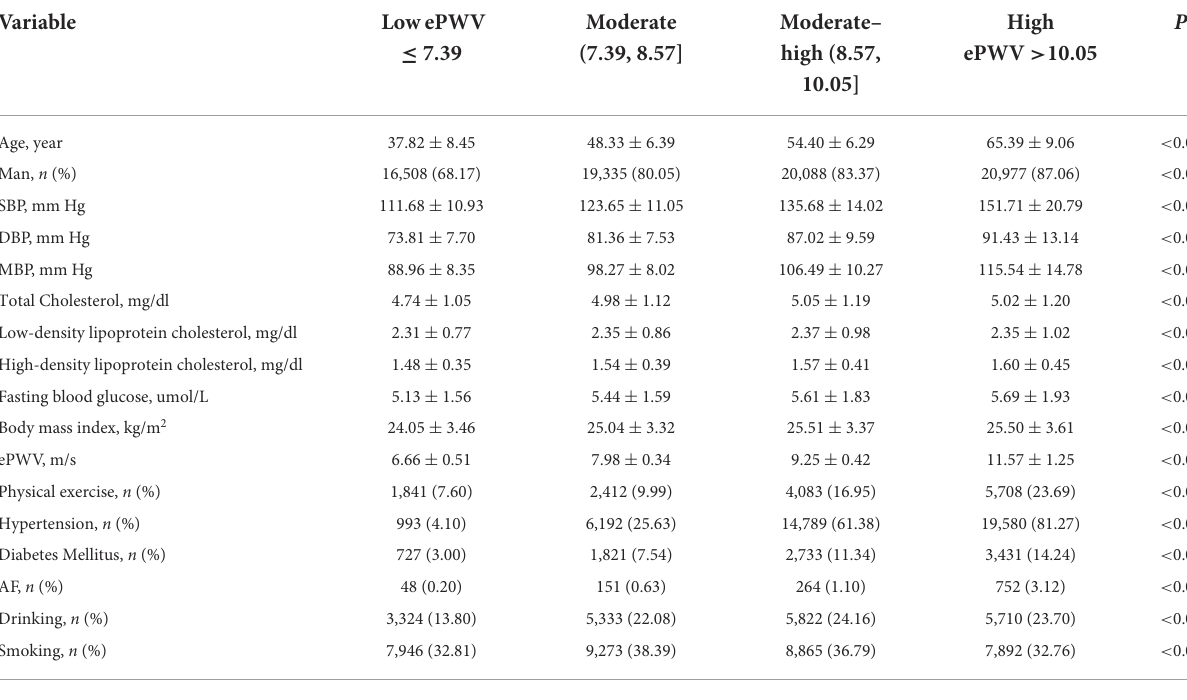
TABLE 1 Characteristics of participants stratified by ePWV.